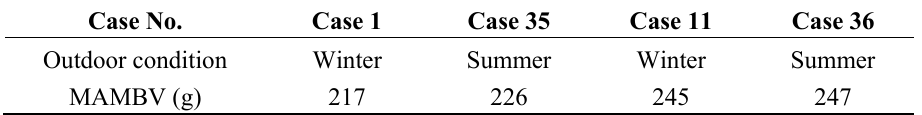
Table 5. Comparison of MAMBV under winter and summer outdoor